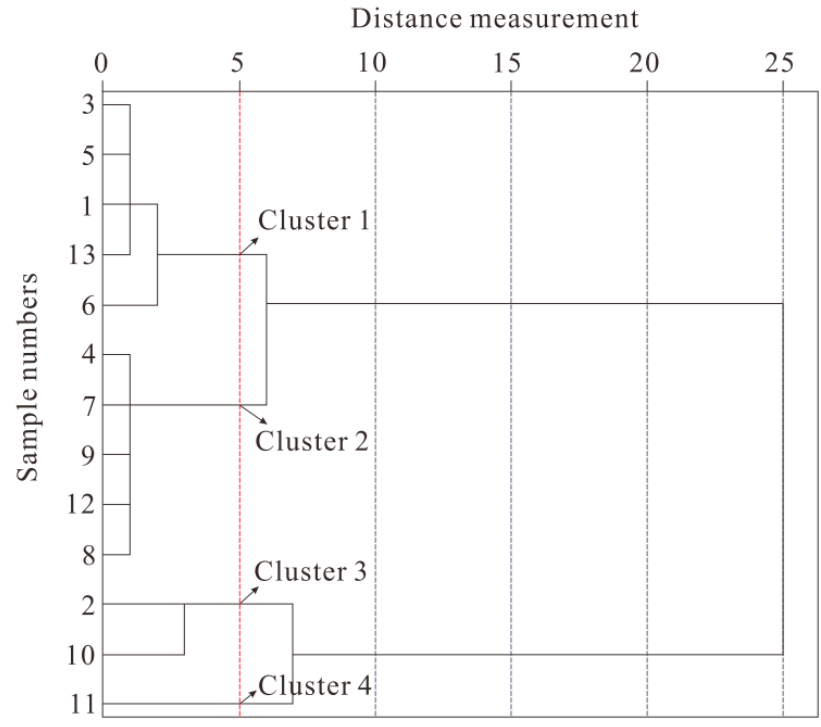
Figure 8. Q-mode cluster analysis of the water samples.